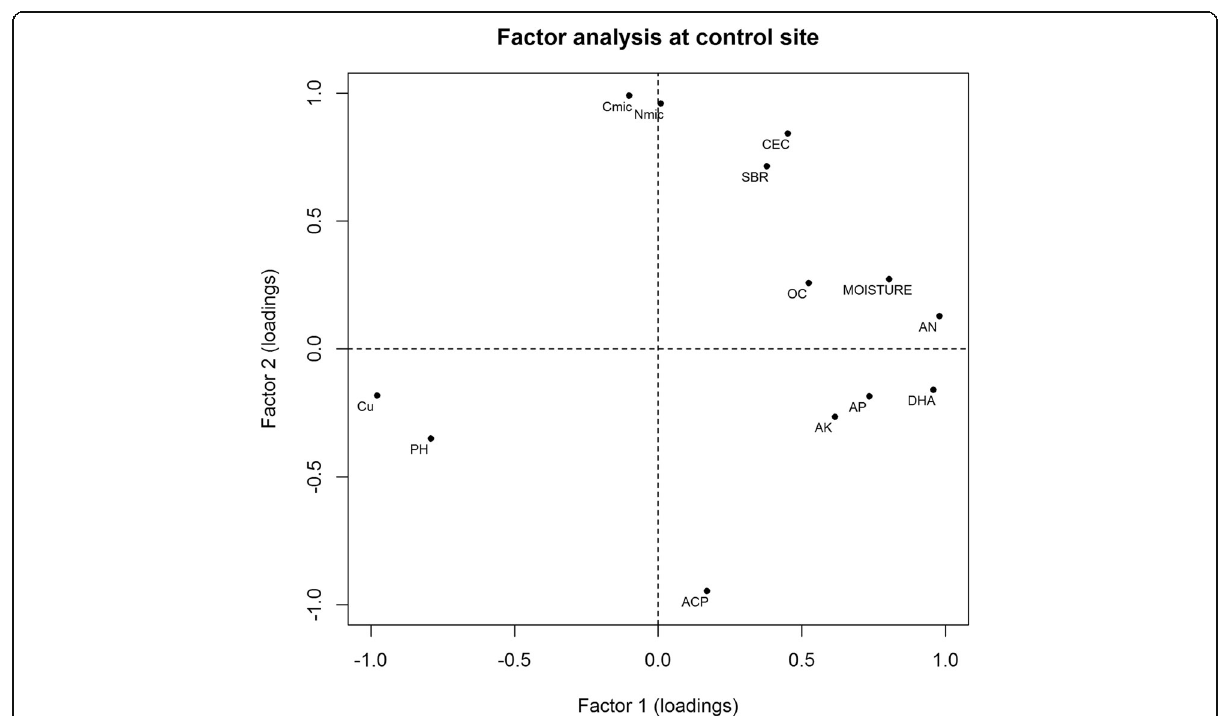
Fig. 4 Two factor components extracted from the variables for physicochemical and microbial properties of control sites of pine and oak forests ( C mic , soil microbial biomass carbon; N mic , soil microbial biomass nitrogen; SBR , soil basal respiration; DHA , dehydrogenase activity; ACP , acid phosphatase activity; OC , organic carbon; CEC , cation exchange capacity; AN , available nitrogen; AP , available phosphorus; AK , available potassium; Cu ,